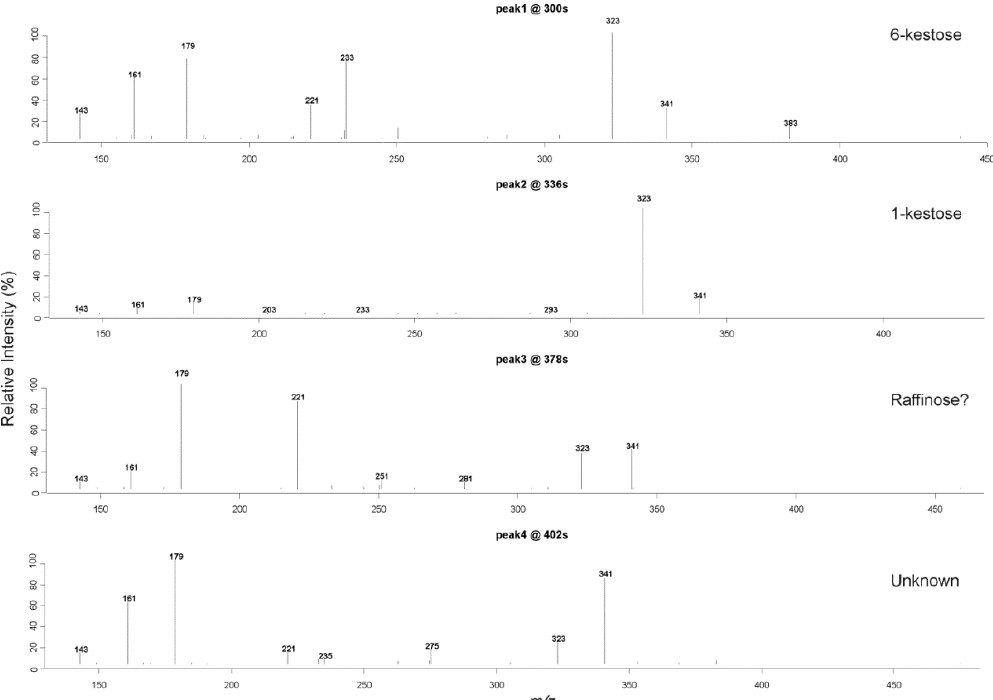
Figure 3. Four MS 2 spectra retrieved from the four clusters with the strongest spectrum from each cluster plotted. The retrieved spectra provide information to infer the four isomeric peaks of m/z 503. With the MS 2 spectra available from authentic compounds, peak 1 can be annotated as 6-kestose, and peak 2 as 1-kestose. Peak 3 can be putatively annotated as